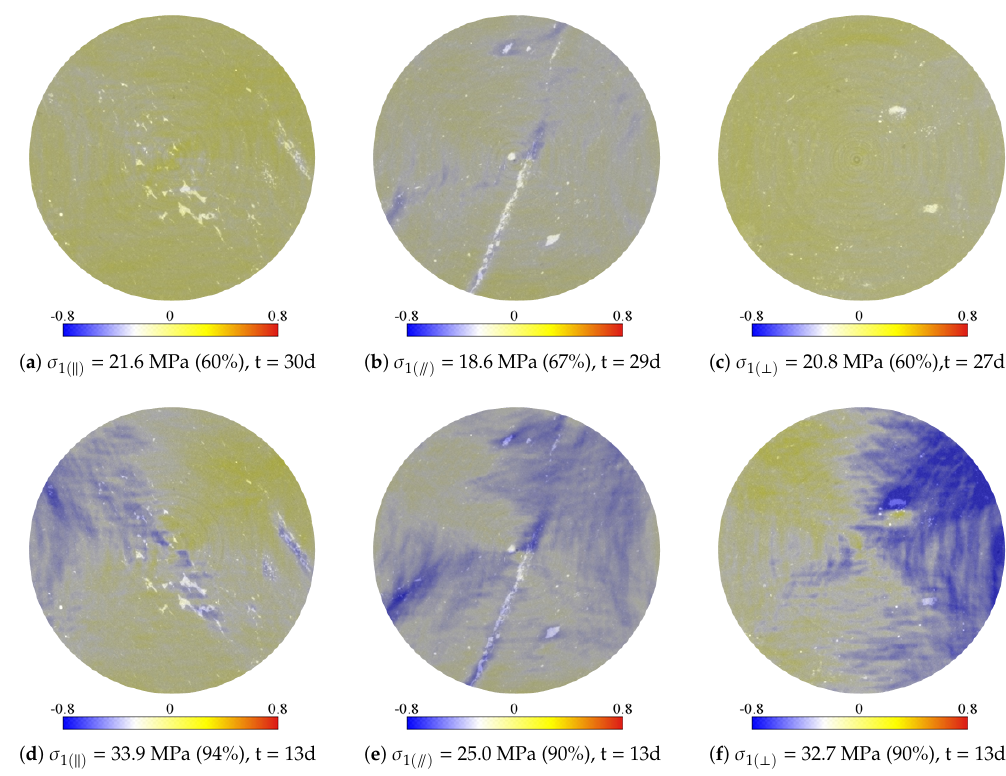
Figure 10. Distributions of accumulated radial strain under two di ff erent stress levels: ( a , d ): slice-680 of parallel sample ( (cid:107) ); ( b , e ) slice-505 of inclined sample ( ∥ ); ( c , f ) slice-500 of perpendicular sample ( ⊥